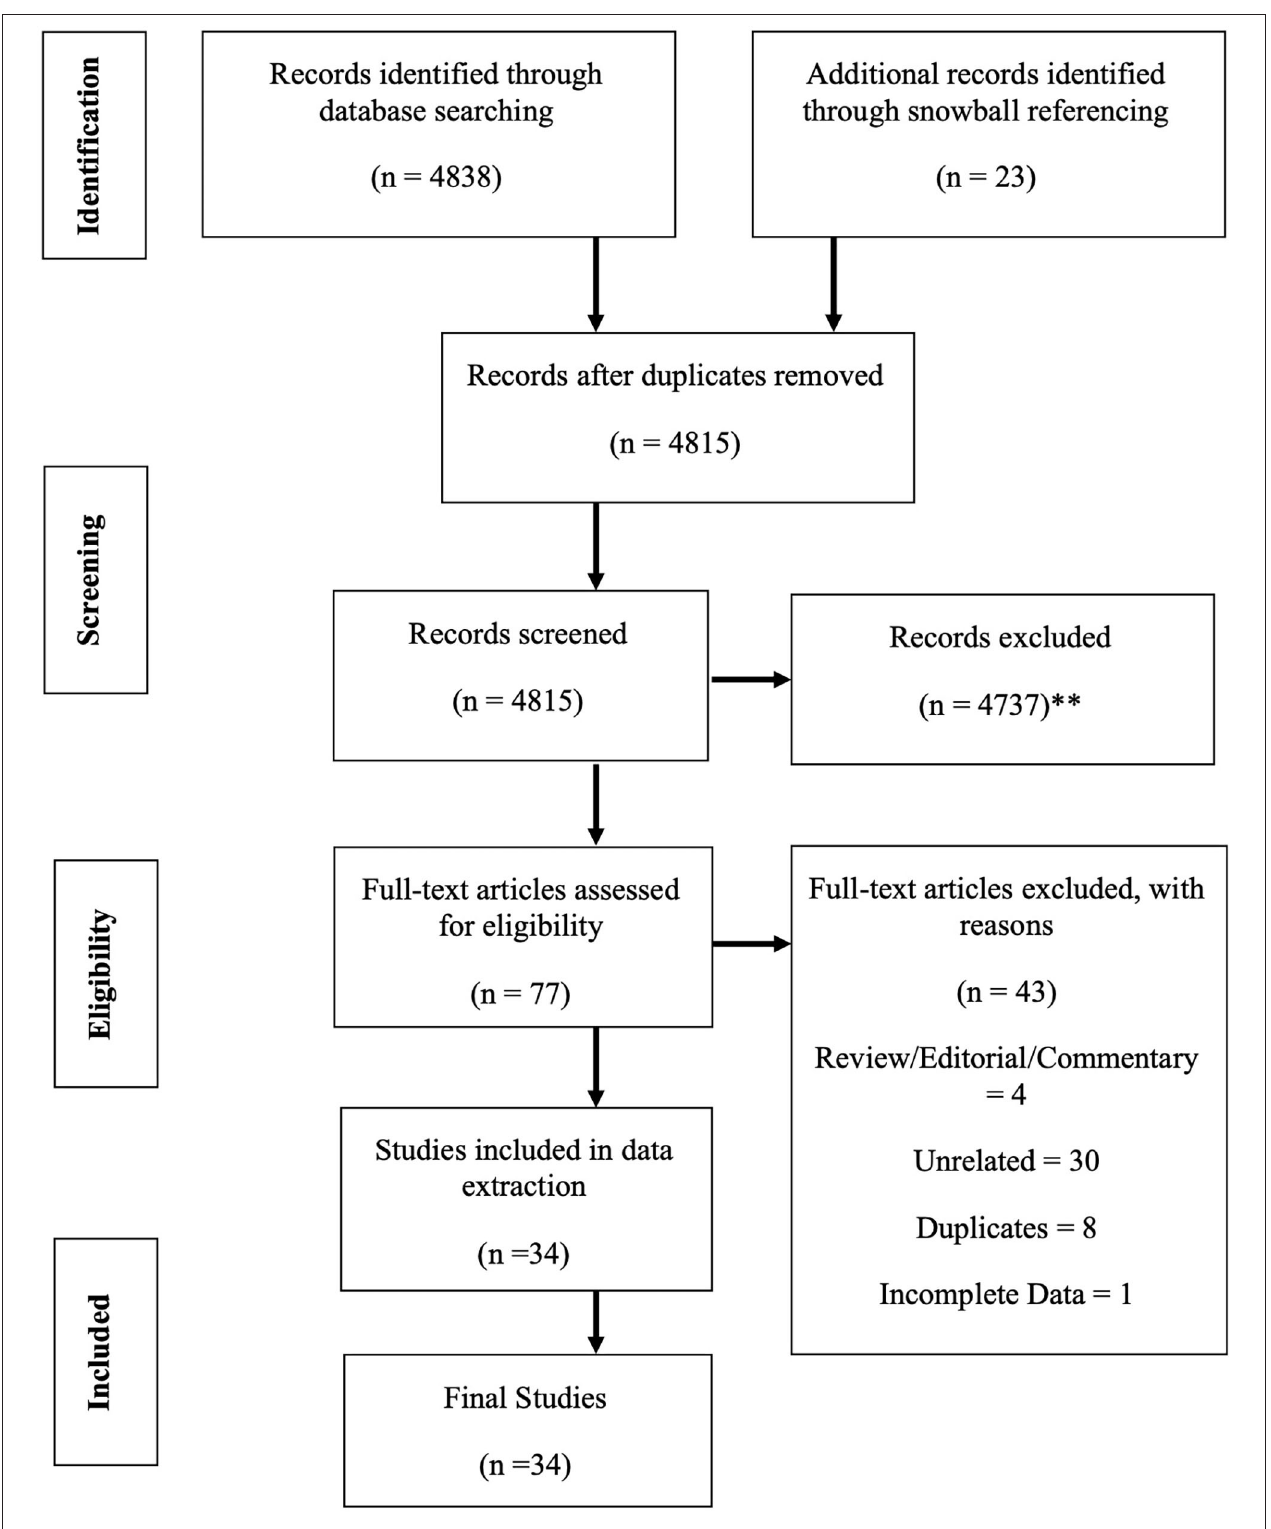
FIGURE 1 | PRISMA flow diagram: the PRISMA (Preferred Reporting Items for Systematic Review and Meta-Analysis) diagram details our search and selection process applied during the overview. (**Reasons excluded are listed in Supplement 1 ).